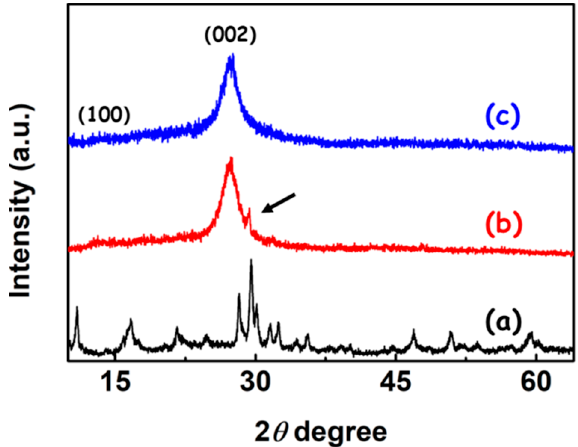
Figure 2. XRD patterns of the as-synthesized samples: (a) PW 9 ; (b) PW 9 /g-C 3 N 4 heterojunction NSs; (c) g-C 3 N 4 NSs.